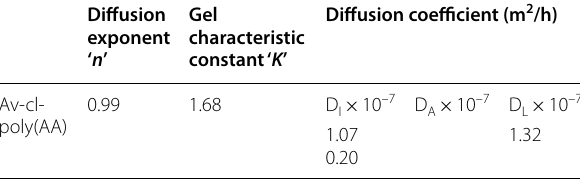
Table 2 Diffusion exponent, gel characteristic constant and diffusion coefficients for the release of dichlorvos through Av-cl-